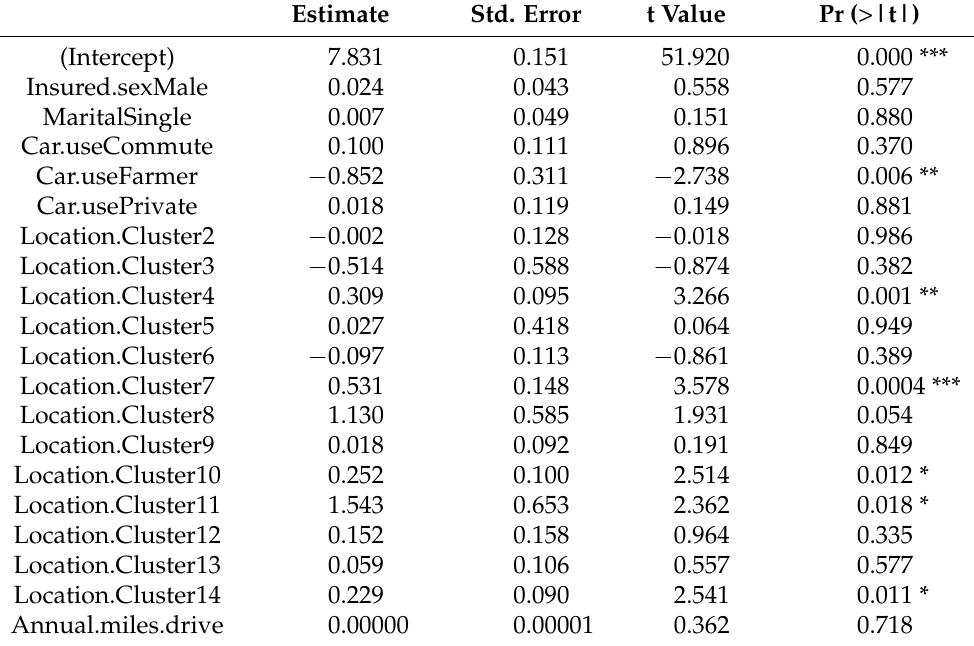
Table 4. The model outputs from GAM (with clusters) used to predict claim amounts.